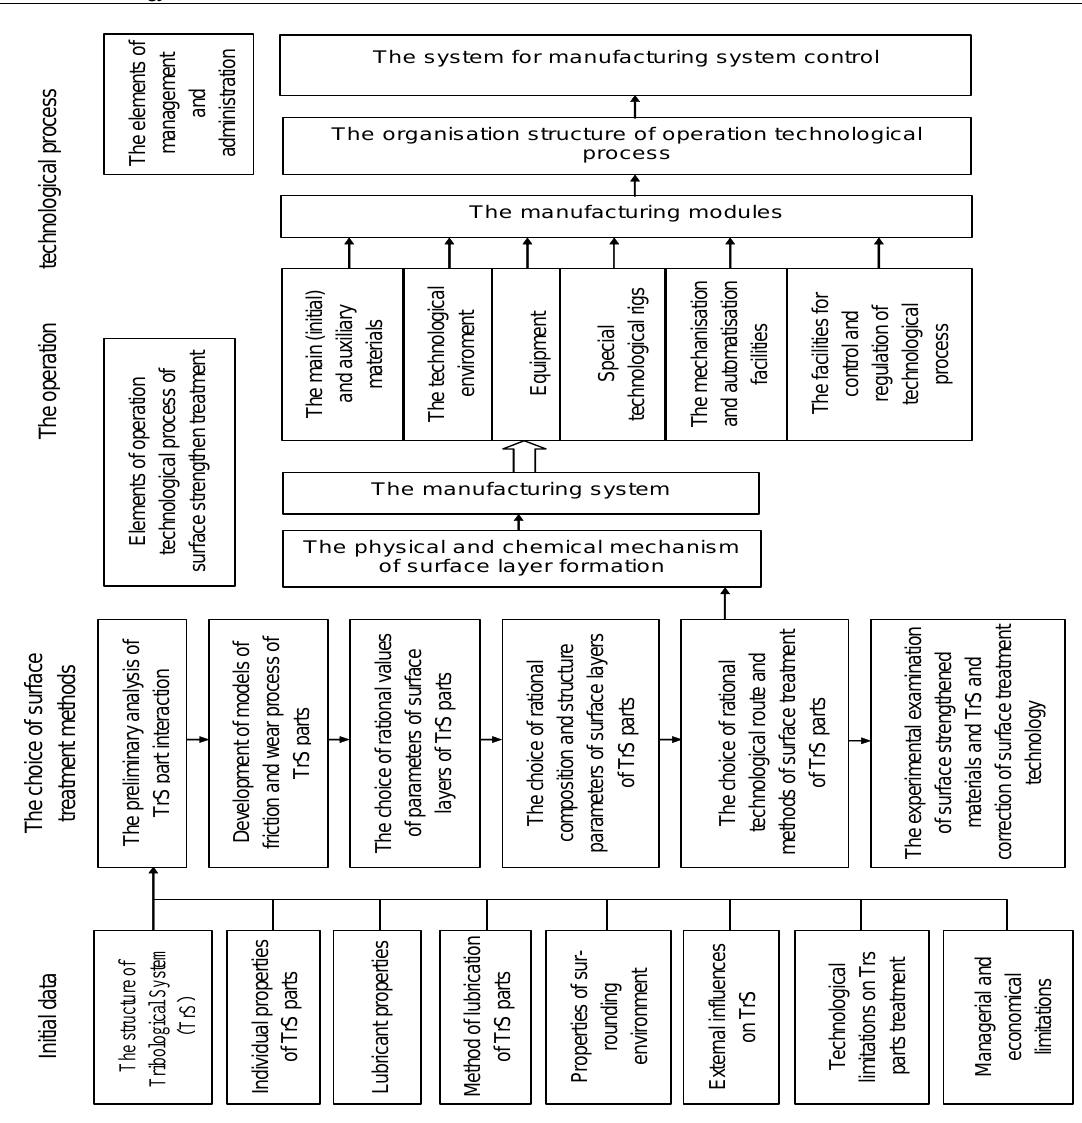
Fig. 1. Scheme of development of operation technology of surface strengthen